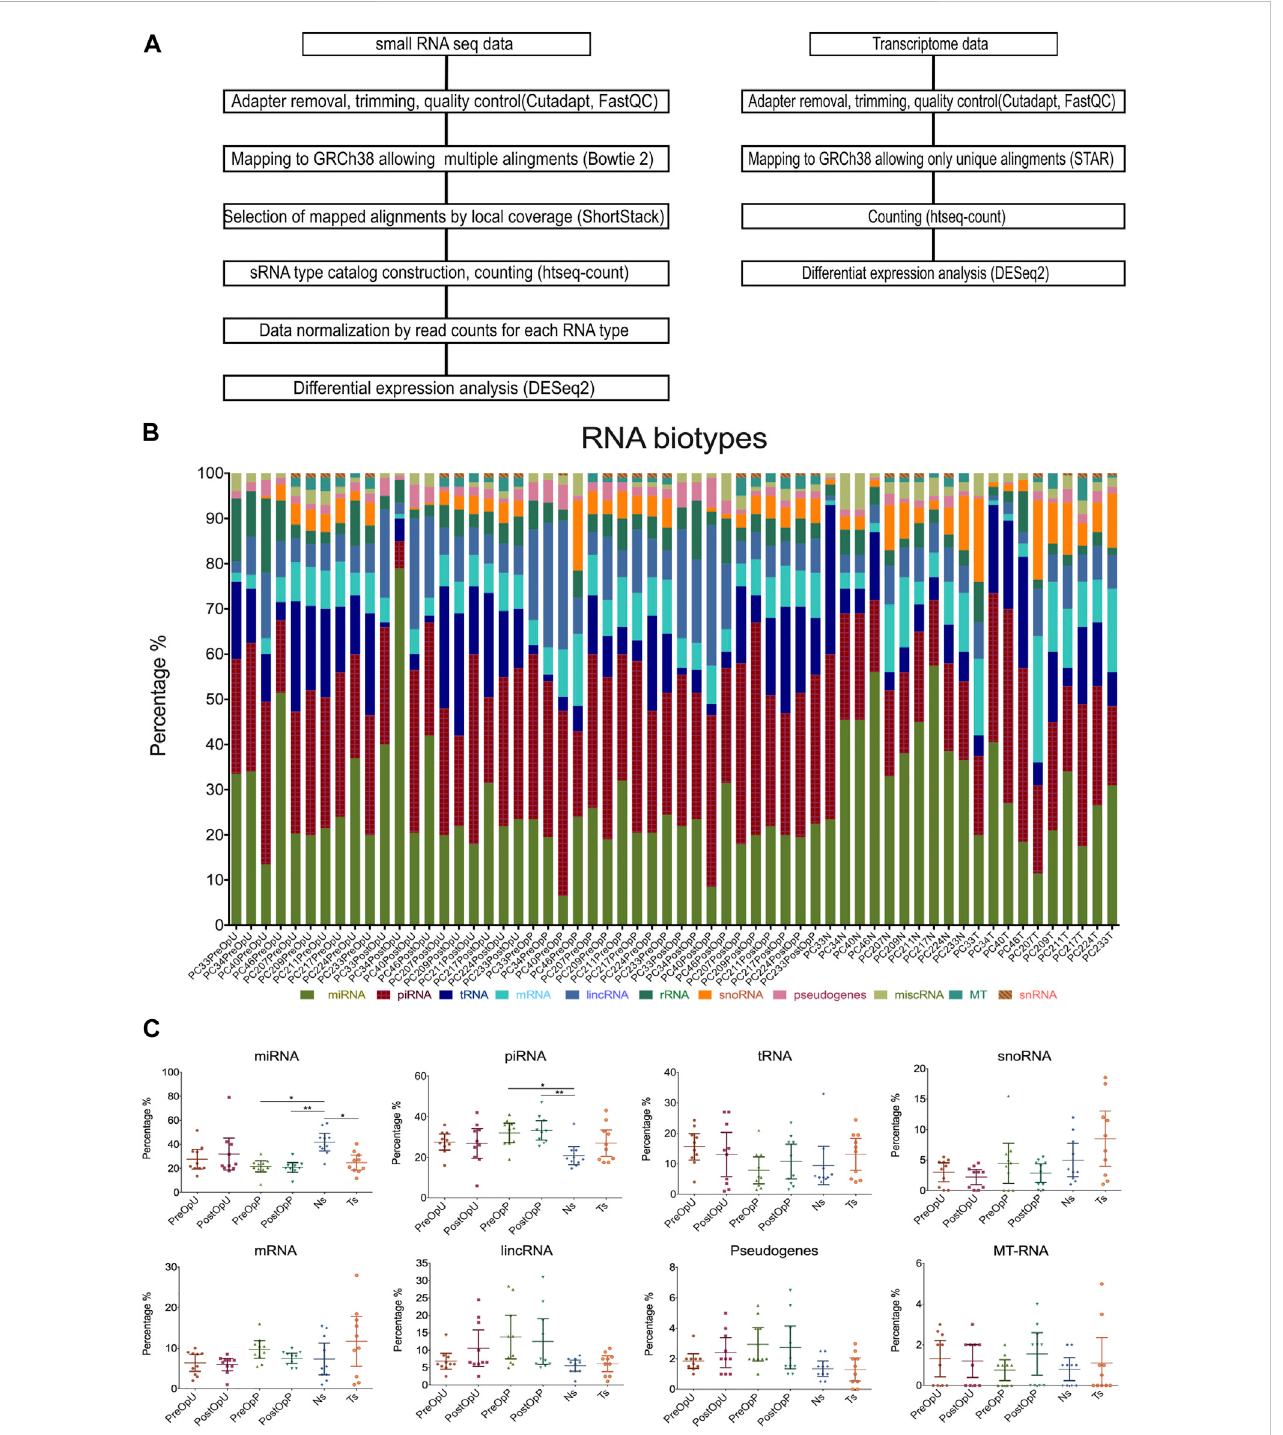
FIGURE 2 RNA biotypes. (A) RNA sequencing data analysis pipeline. (B) Percentage of reads representing various RNA biotypes in each sample. (C) Dot plots showingthecomparisonofspeci fi cRNAbiotypesinthegroupsofsamples. Kruskal — Wallistestwith multiplecomparisonscorrected byDunn ’ stestwasused to assess the statistical signi fi cance of the differences between groups. * p < 0.5; ** p < 0.01; *** p < 0.001. PreOpU — urinary EVs before radical prostatectomy, PostOpU — urinary EVs after radical prostatectomy; PreOpP — plasma EVs before radical prostatectomy, PostOpP — plasma EVs after radical prostatectomy, N — normal prostate tissue, T — tumor